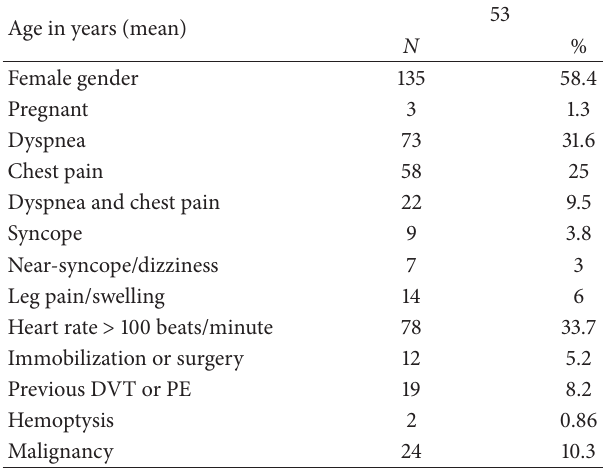
Table 2: Clinical characteristics of 231 patients suspected of having